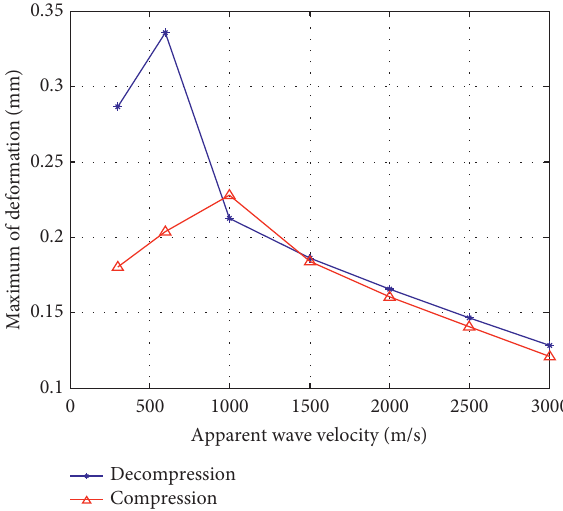
Figure 22: Deformation vs. apparent wave velocity.